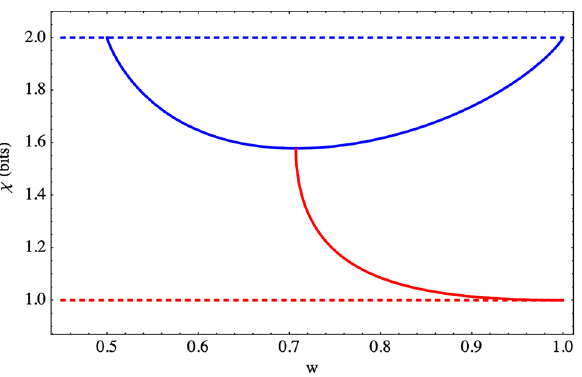
Figure 1. Information Capacity χ with respect to the probability w for the Prisoner’s Dilemma (dashed lines) and Battle of the Sexes (continuous lines) discussed in the text. Depicted in the figure are the classical strategies (online blue) and quantum strategies (online